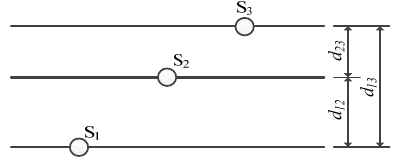
Figure 11. Closure property for a plane wave.